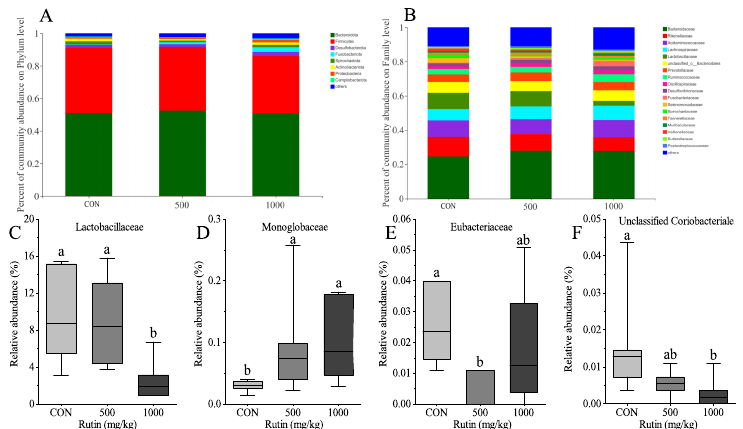
Figure 3. Beta diversity of caecal microflora composition in aged laying hens. ( A , B ) bar plots of microbial composition at phylum ( A ) and family ( B ) levels; ( C – F ), significantly differential bacteria taxa at family levels. Data are presented as mean ± SEM and analyzed by Kruskal-Wallis H test. Different lower-case letters indicate a significant difference among different groups ( P <